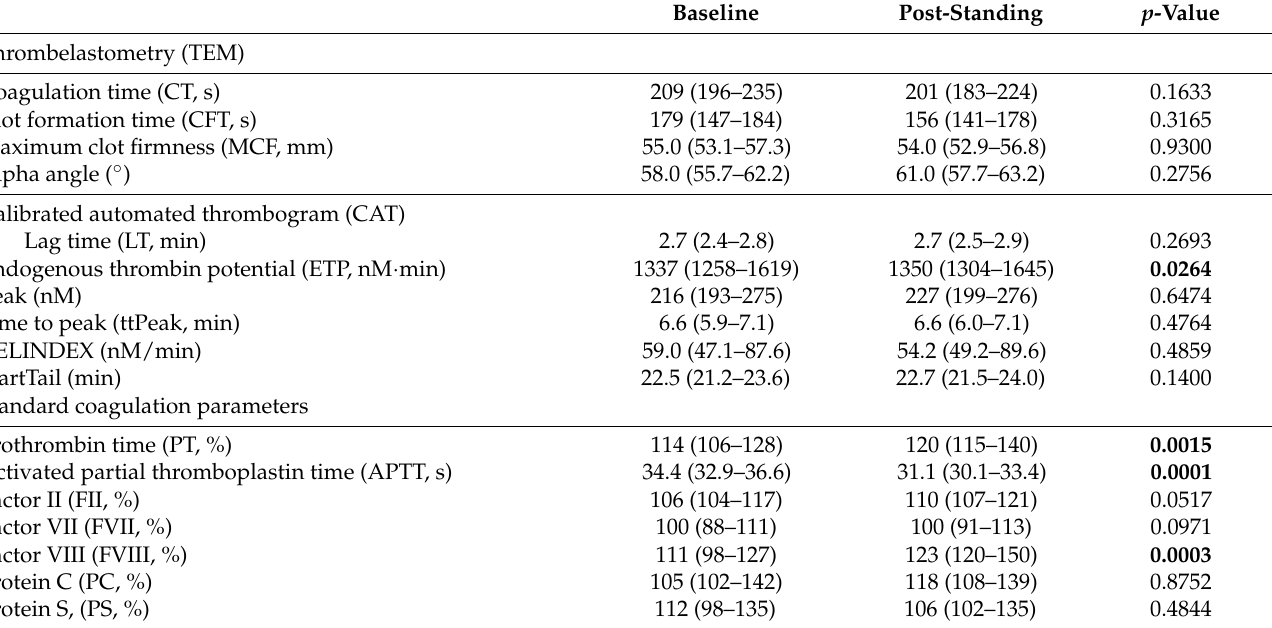
Table 3. Effect of orthostatic challenge on coagulation values in young participants (n = 20). Data are expressed as median ± 95% CI. p -values were calculated by means of the Wilcoxon matched pairs signed-rank